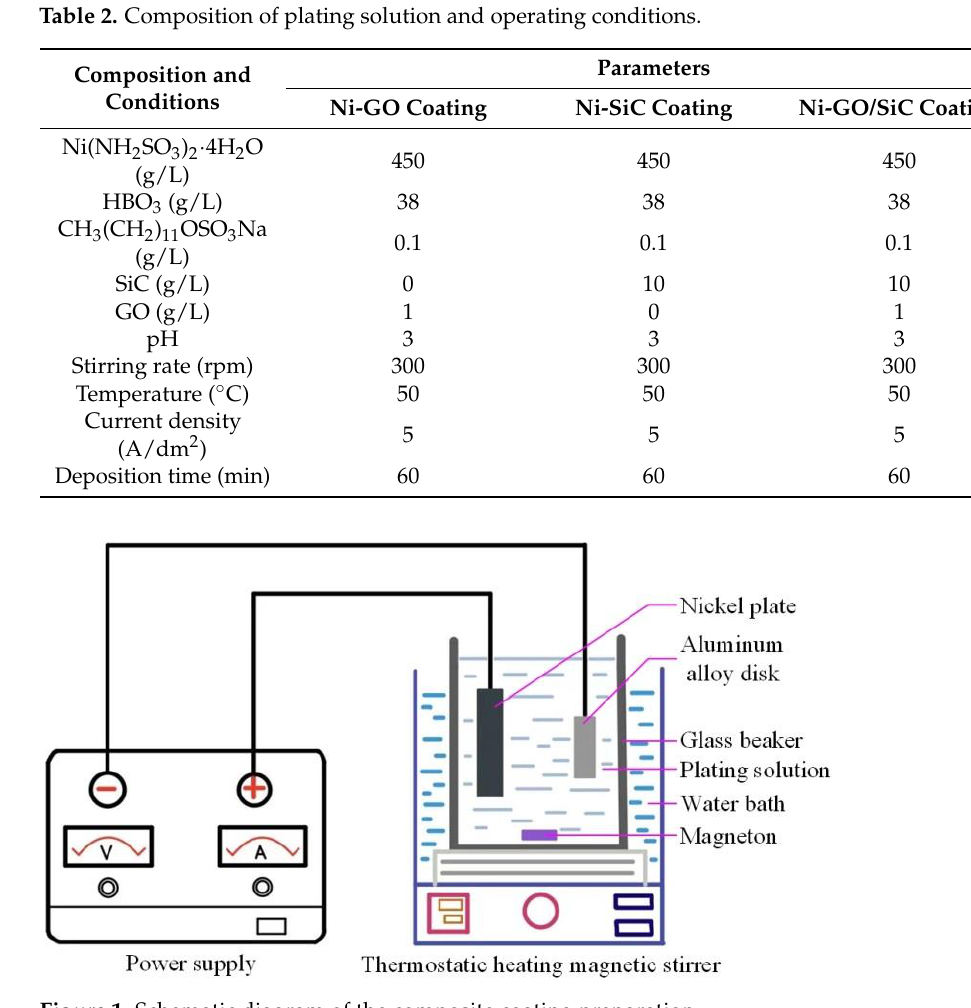
Figure 1. Schematic diagram of the composite coating preparation.